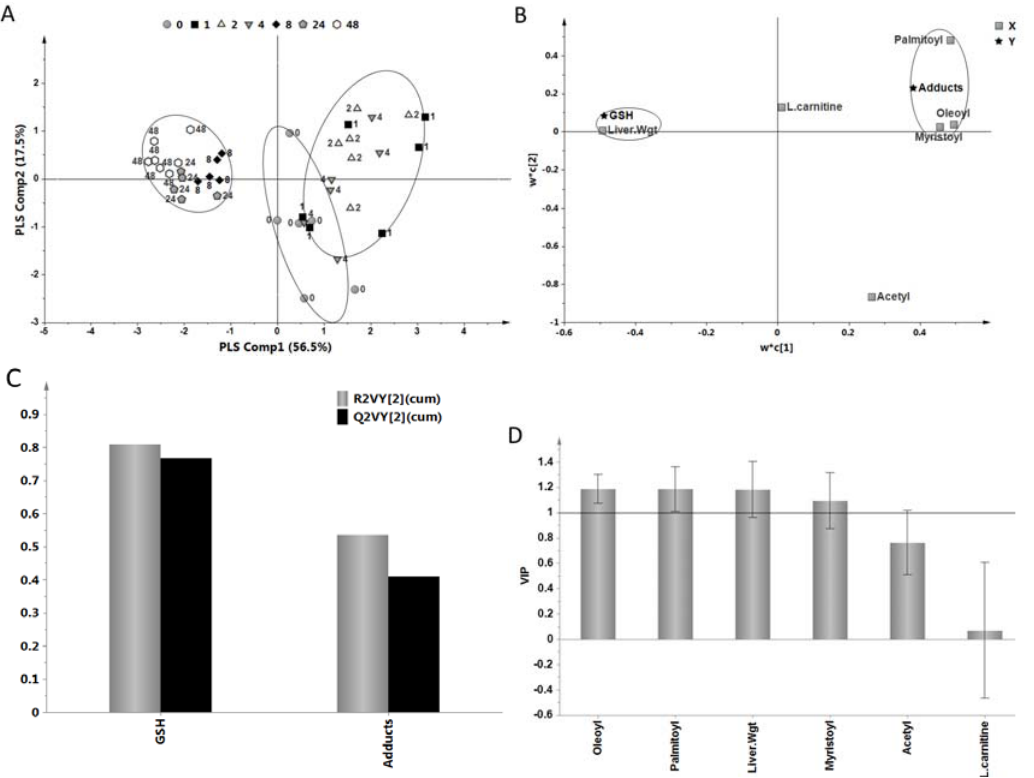
Figure 7. Partial least squares regression model describing the relationship between L -carnitine, acetyl, palmitoyl, oleoyl, myristoyl carnitine, liver weight, hepatic GSH and APAP protein adducts. ( A ) Scores plot of the samples showing the separation between the different time point groups (6 animals per group) along the two PLS components. The 8, 24 and 48 h time points clearly separated from the earlier time points (1, 2 and 4 h) and pre-dose (0) along the first PLS component. The goodness of fit (R 2 ) and goodness of predictability (Q 2 ) of the model were ~74% and 58.9%, respectively. ( B ) The corresponding loadings plot of the model showing the relationship between the acylcarnitine predictors and the toxicity/metabolism markers along the two partial least squares (PLS) components. The plot shows that palmitoyl, oleoyl and myristoyl carnitine correlated well to APAP protein adducts, while L-carnitine had minimal contribution to the model. ( C ) Explained variation of the two responses after the two PLS components in the model. Hepatic GSH and APAP protein adducts were well explained by the model and GSH performed slightly better based on the R 2 V(Y) and Q 2 V(Y) values. ( D ) VIP plot of the predictors showing their pooled contribution over the PLS component and all three